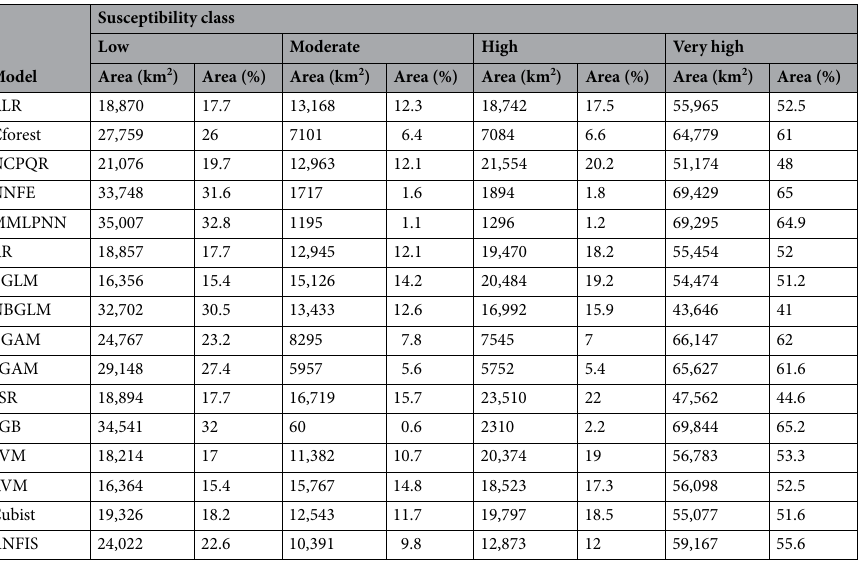
Table 2. Land susceptibility classes to wind erosion hazard calculated by 16 individual ML